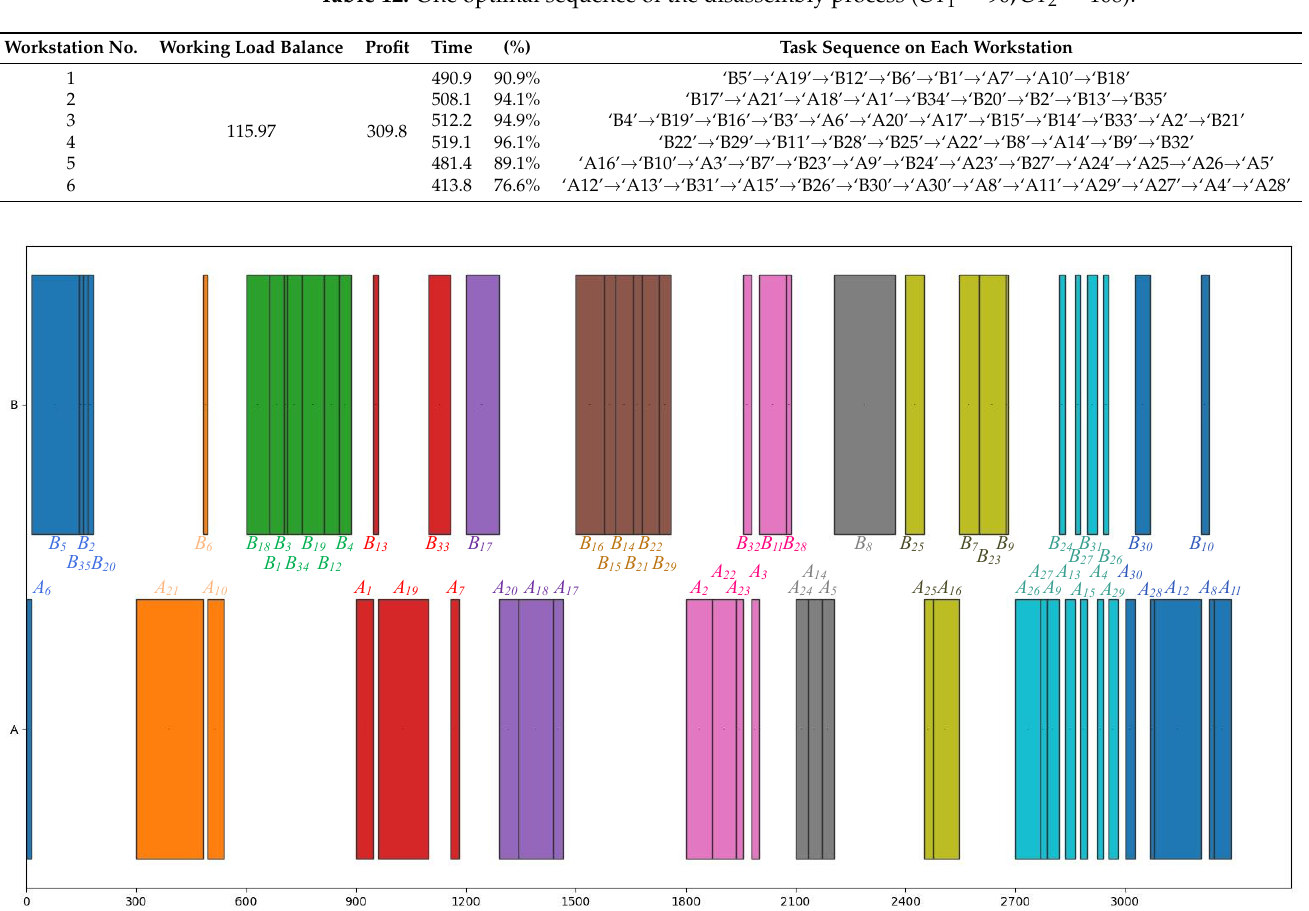
Table 12. One optimal sequence of the disassembly process ( CT 1 = 90, CT 2 = 108).